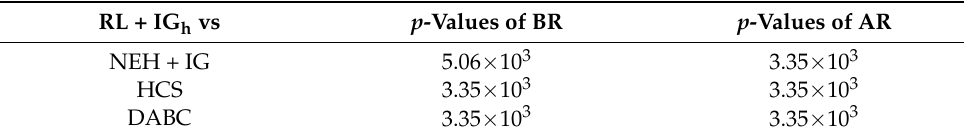
Table 7. Results achieved by Wilcoxon test.